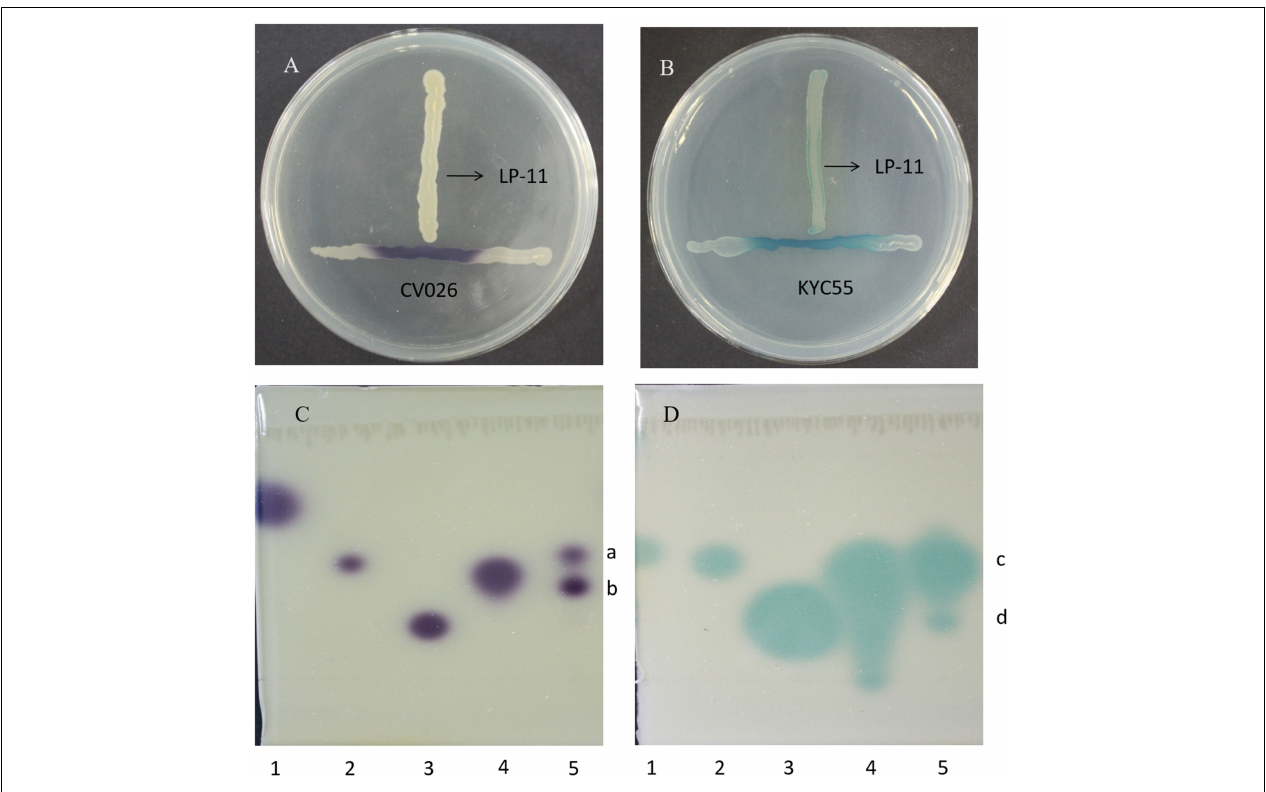
FIGURE 2 | The detection of AHLs in A. veronii LP-11 in ‘T’ streak assay using biosensor (A) A. tumefaciens KYC55 and (B) C. violaceum CV026 and the detection of AHLs in A. veronii LP-11 extract by TLC using biosensor (C) A. tumefaciens KYC55 and (D) C. violaceum CV026. Lane 1, standard C4-HSL; lane 2, standard C6-HSL; lane 3, standard C8-HSL; and lane 4, standard 3-oxo-C8-HSL; and lane 5, A. veronii LP-11